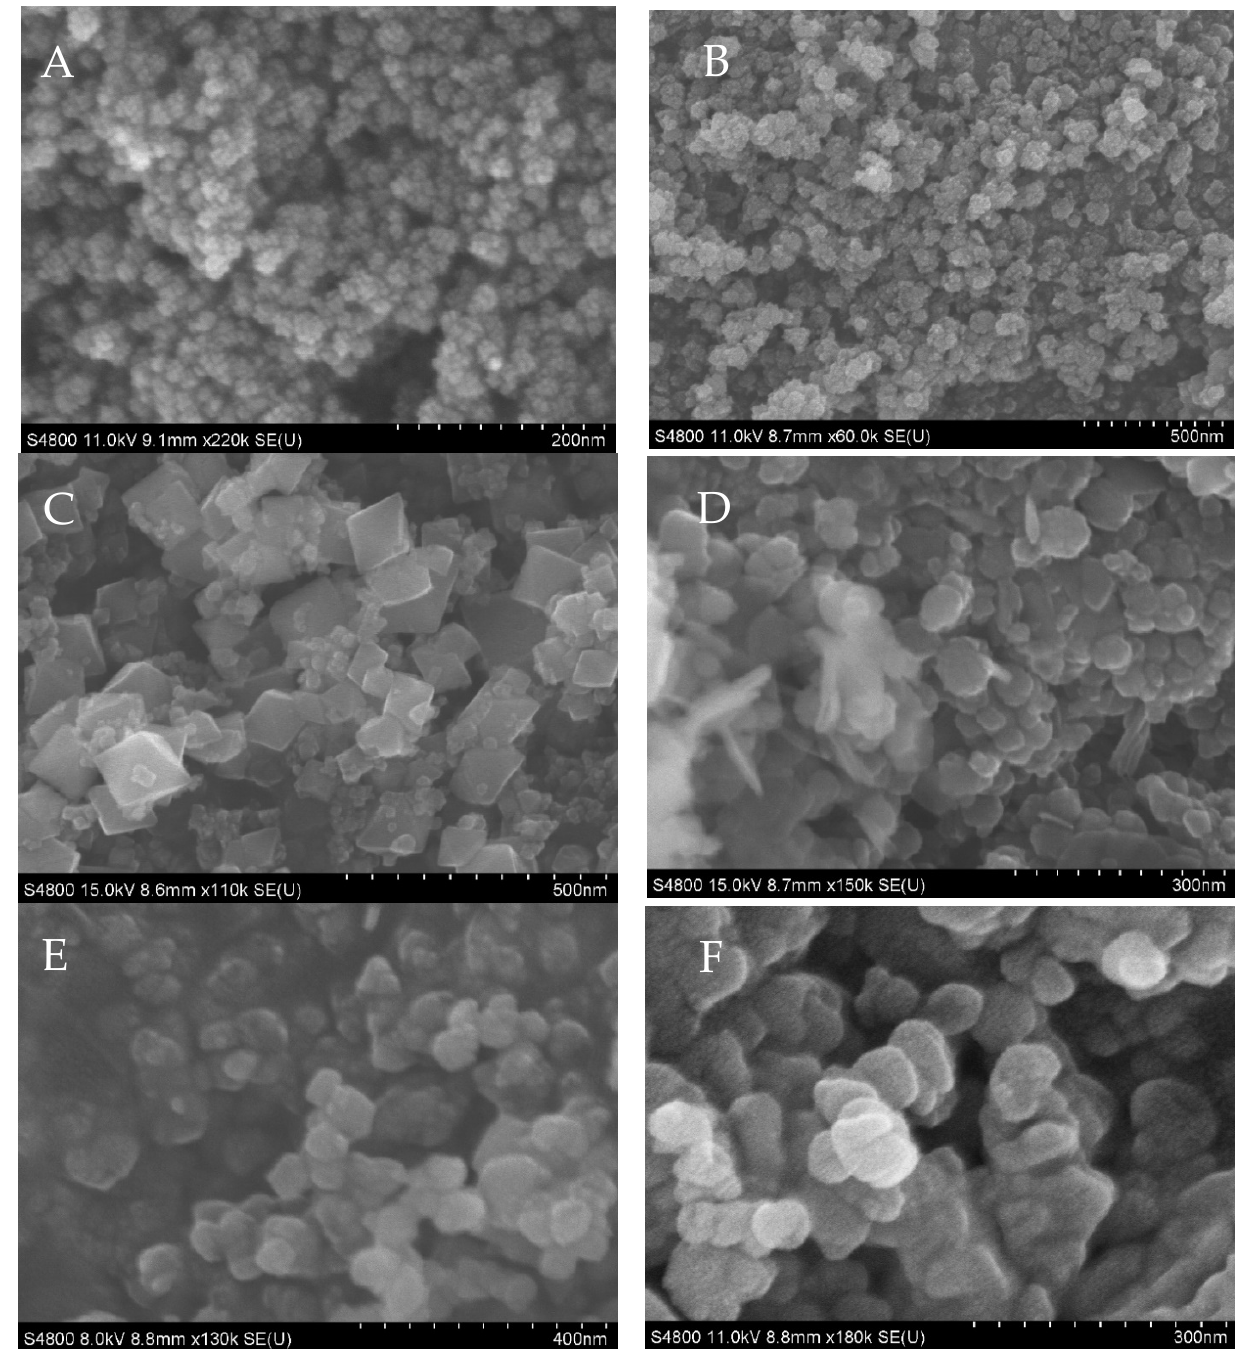
Figure 2. SEM Images of ( A ) Fe 3 O 4 , ( B ) MnFe 2 O 4 , ( C ) ZnFe 2 O 4 , ( D ) Zn 0.5 Mn 0.5 Fe 2 O 4 , ( E ) Mn 3 O 4 , and ( F ) ZnO.